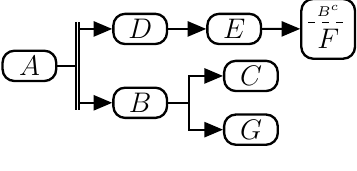
Figure 3. Dependencies between the operations in Example 1.